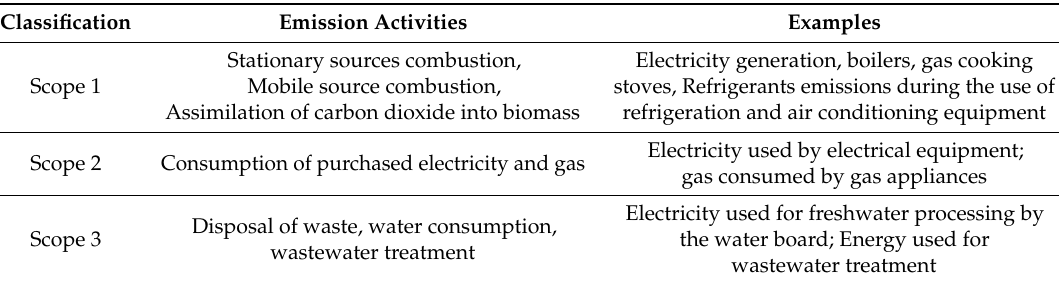
Table 2. Scopes of emissions considered in the study.